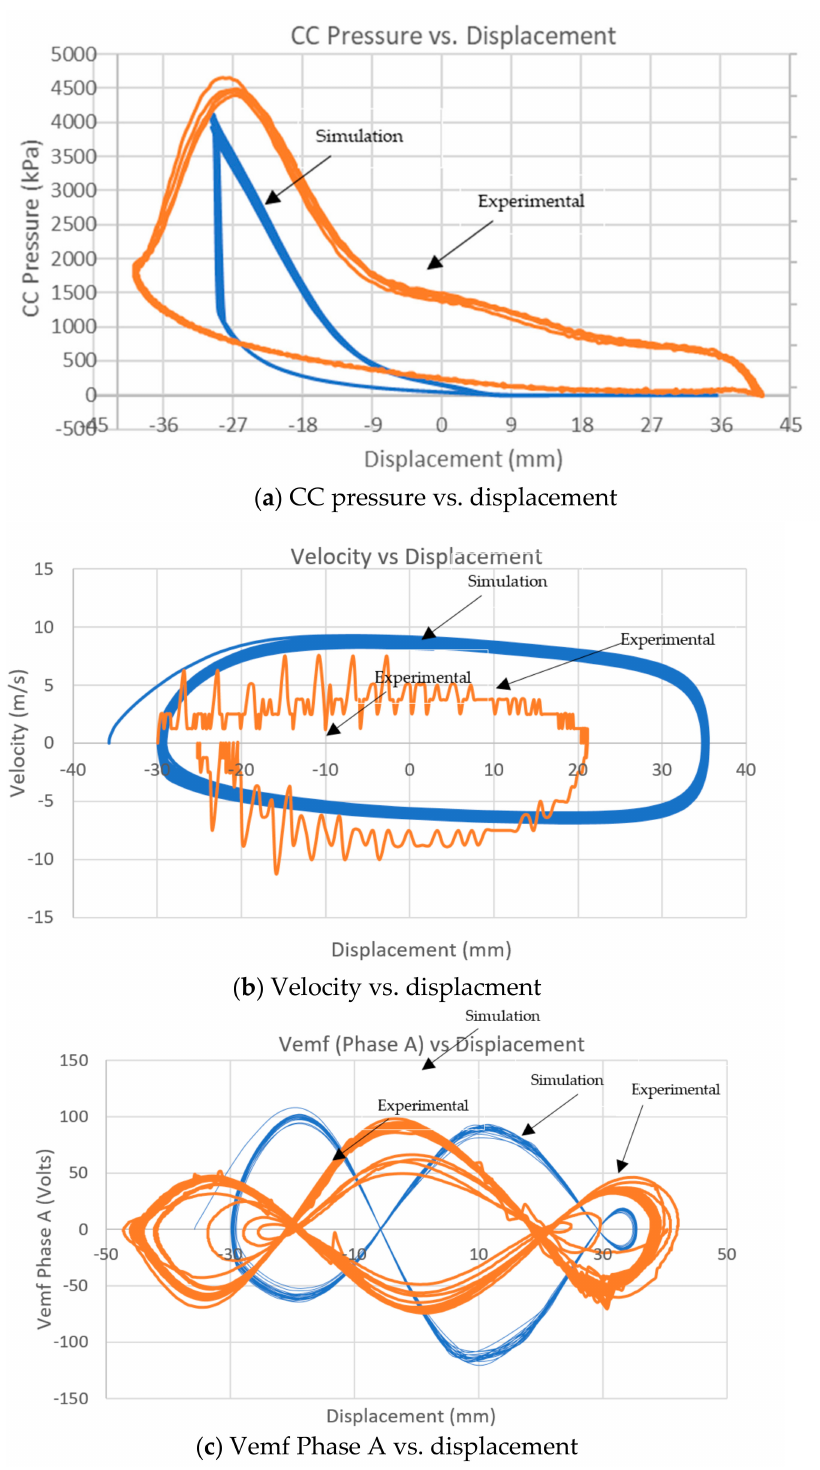
Figure 17. ( a ) CC pressure vs. displacement, ( b ) displacement vs. velocity, ( c ) Vemf Phase A vs. displacement at CF 0.94 ±